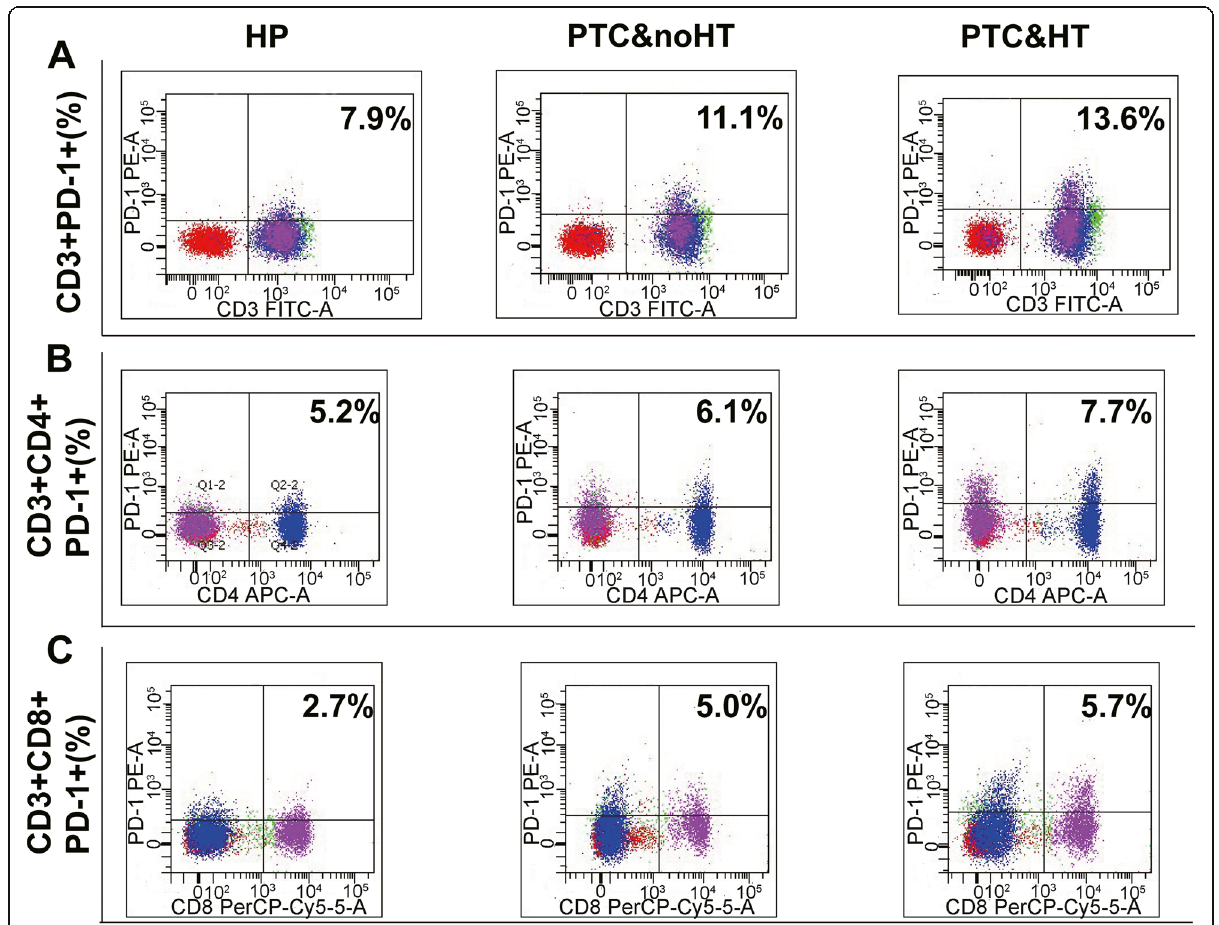
Fig. 3 The expression of PD-1 in peripheral blood of HP, PTC&noHT and PTC&HT. A. The CD3 + PD-1+ expression among HP, PTC&noHT and PTC&HT. B. The CD3 + CD4 + PD-1+ expression among HP, PTC&noHT and PTC&HT. C. The CD3 + CD8 + PD-1+ expression among HP, PTC&noHT and PTC&HT(*P<